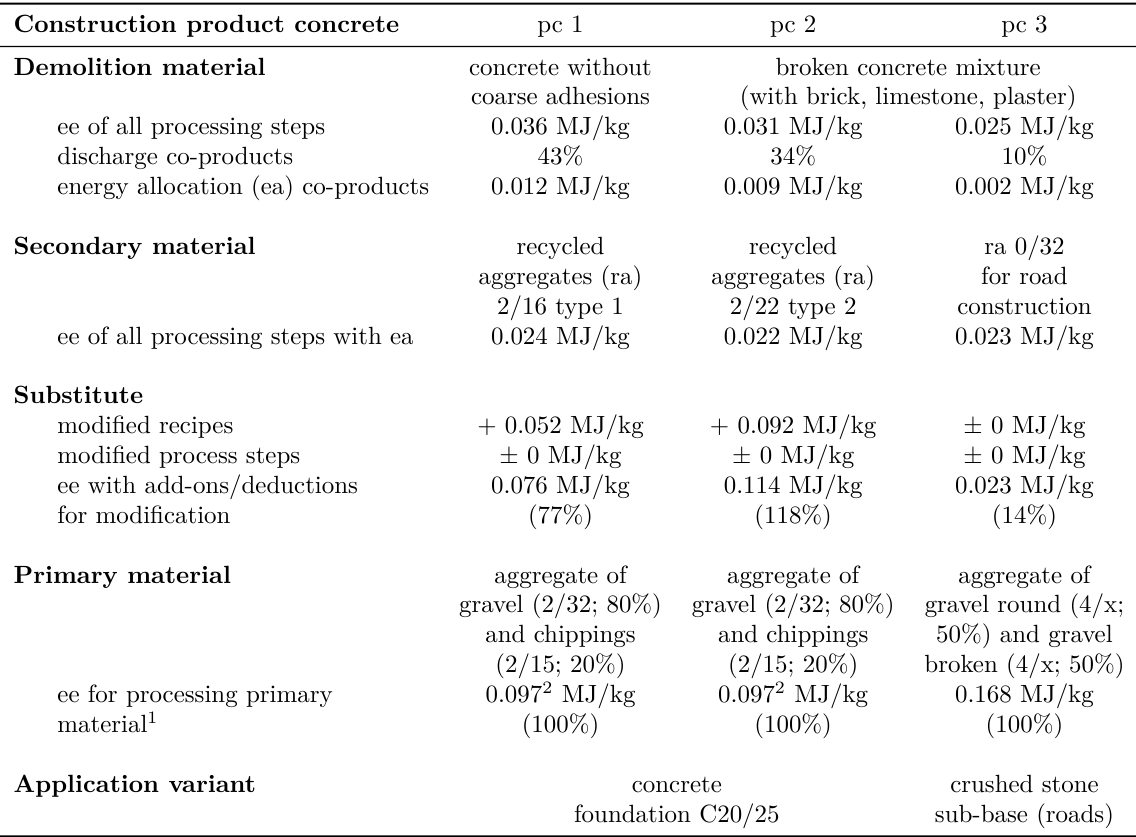
Table 3. Energy expenditure (ee) calculations of the di ff erent pc of